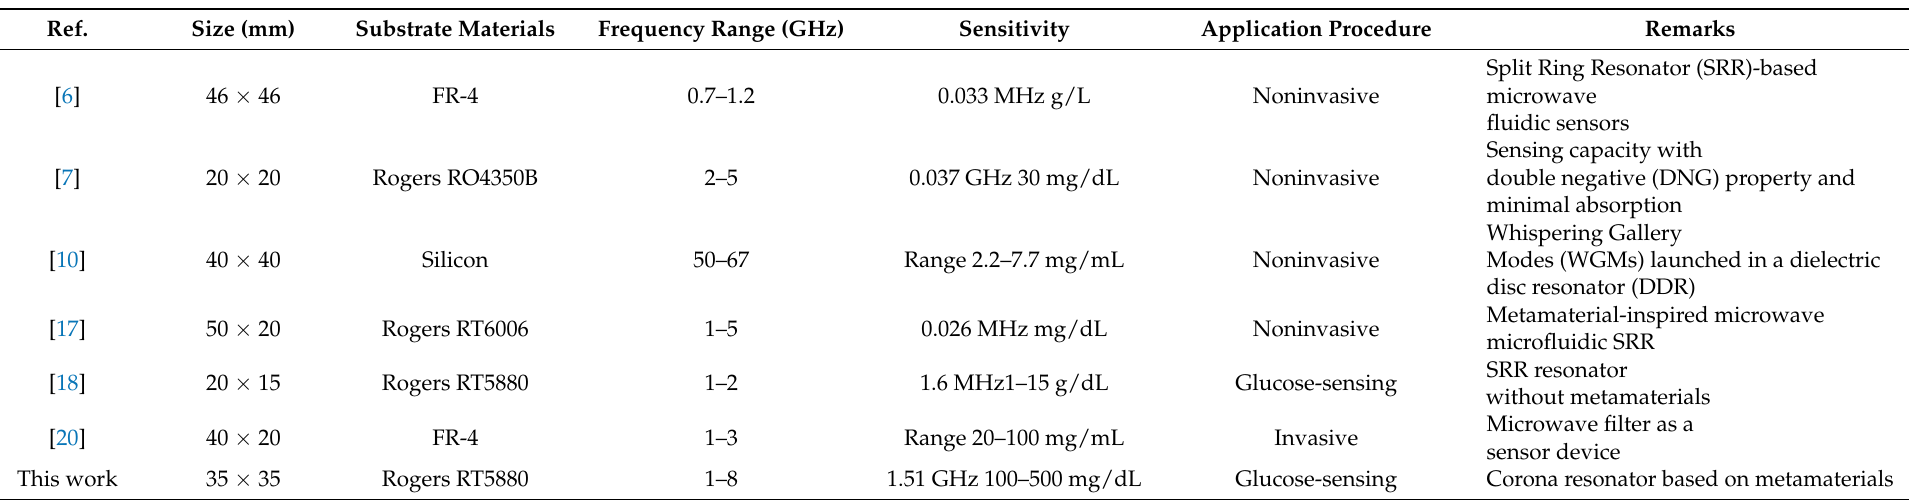
Table 2. Comparison study of the proposed glucose sensor with those reported in